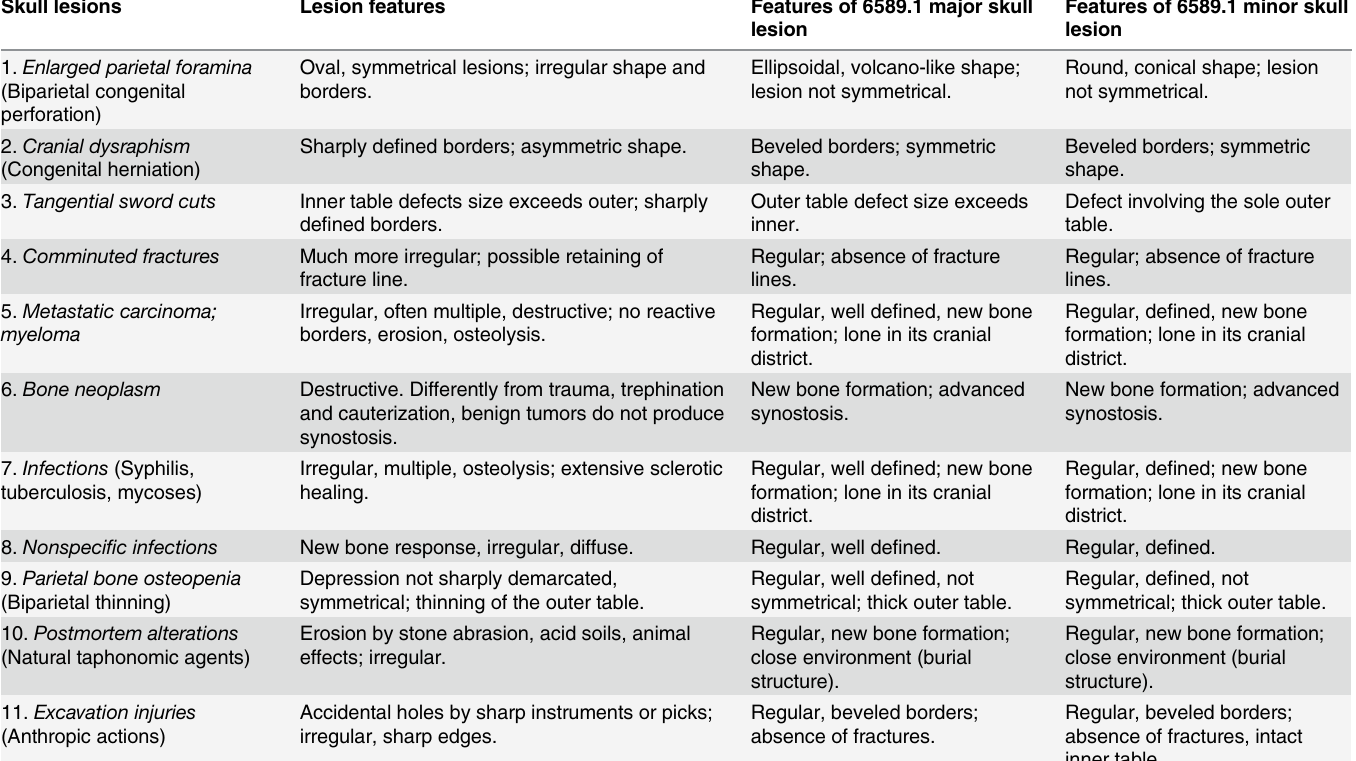
Table 2. Differential diagnosis for skull trephination (modified from Steinbock, 1976, Aufderheide et al., 1997, and Ortner, 2003). Skull lesions